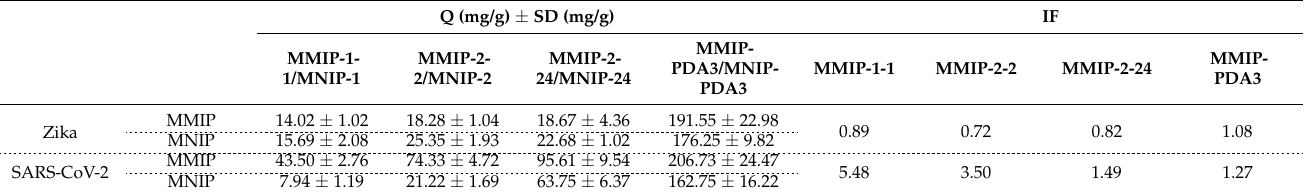
Table 4. MMIP/MNIP selectivity study using SARS-CoV-2 and Zika peptides. Q (mg/g) ± SD